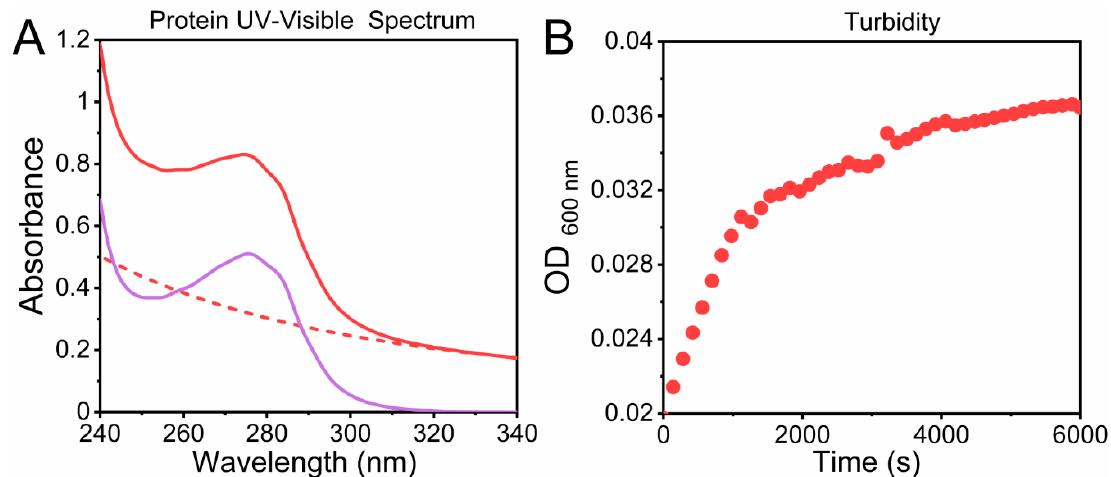
Figure 4. ( A ) Protein Spectrum (240–320 nm) where a high scattering contribution is observed (solid red line), the light scattering component (red dashed line) and the corrected spectrum (solid violet line). ( B ) Turbidity measurement of the aggregation process of C- terminal domain of TDP-43 protein in the presence of 300 mM NaCl. Here, the optical density at 600 nm was followed over